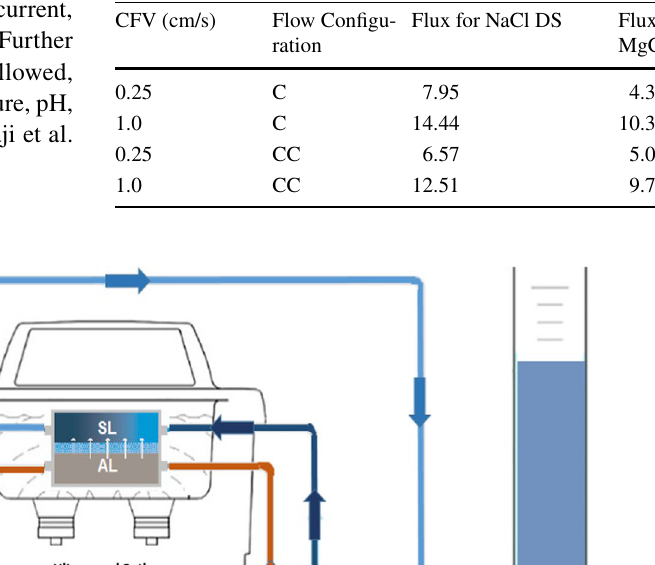
Table 2 Average flux (L/m 2 ·h) under baseline conditions for